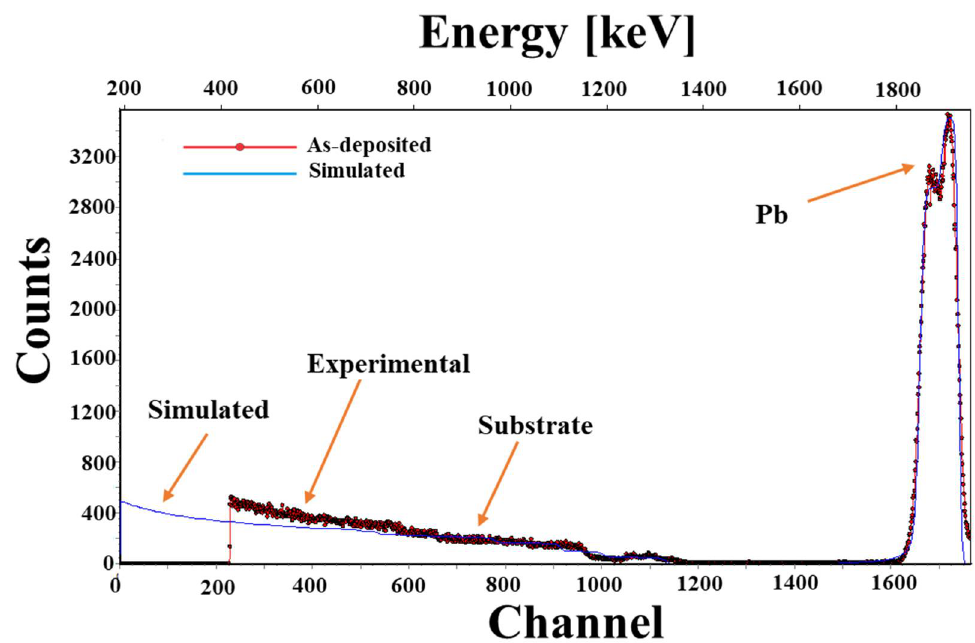
Figure 4. RBS spectra of PbS thin film of as-deposited sample.